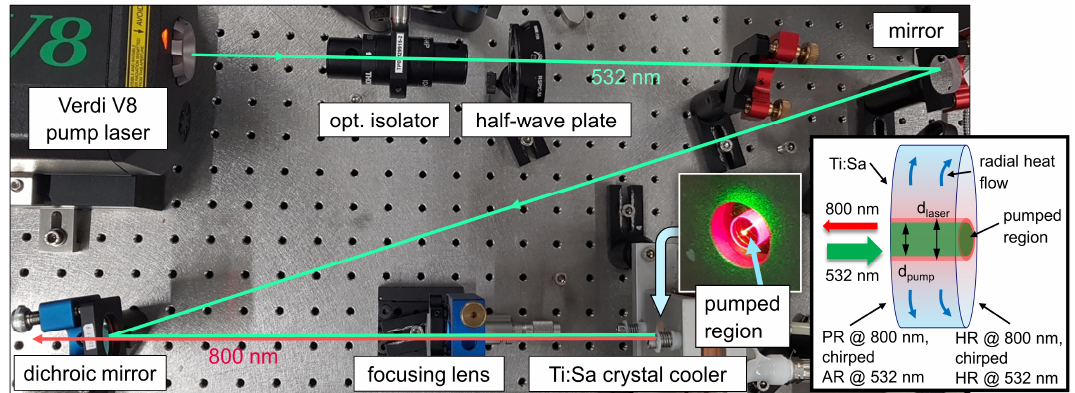
Fig. 1 Experimental pumping setup of the Ti:Sa crystal. The schematic illustration of the monolithic mode-locked Ti:Sa laser shows the coatings on both end faces and the predominantly radial heat flow. A first batch of 3 mm Ti:Sa crystals was coated and tested. The pump source is a frequency-doubled stabilized single-frequency Nd:YVO 4 laser at 532 nm. With an incident pump power of up to 8.5 W and 60% absorption, output powers up to 1.8 W with power stability of ≤ 0.04% rms over one hour and 10 nm bandwidth are produced. The interferometric autocorrelation shows a contrast of just 3:1 instead of 8:1 which indicates that we are not seeing mode-locked pulses [4]. The laser beam was then sent into a pulse stretcher introducing 10 4 fs² and later 10 6 fs² of group delay dispersion and then measured again by the autocorrelator. The measured autocorrelation trace did not change. This suggests that we have not achieved mode-locking but are simply seeing white light interference of the laser